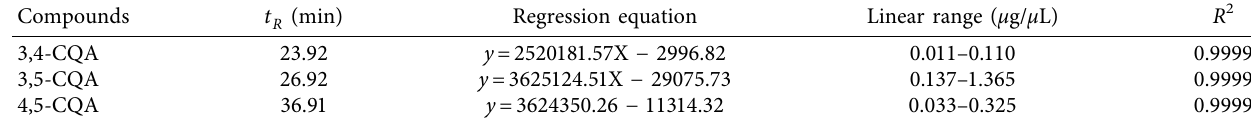
Table 2: Retention time, regression equation, and linear range of three marker